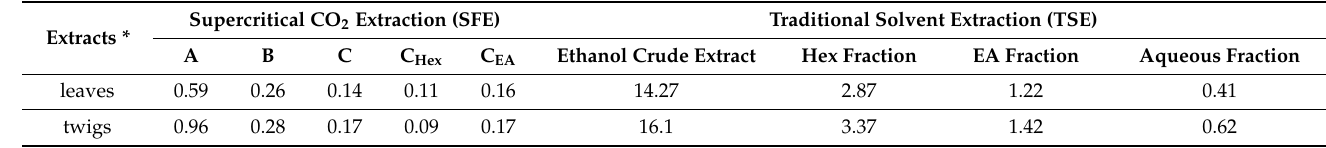
Table 1. Extraction yields